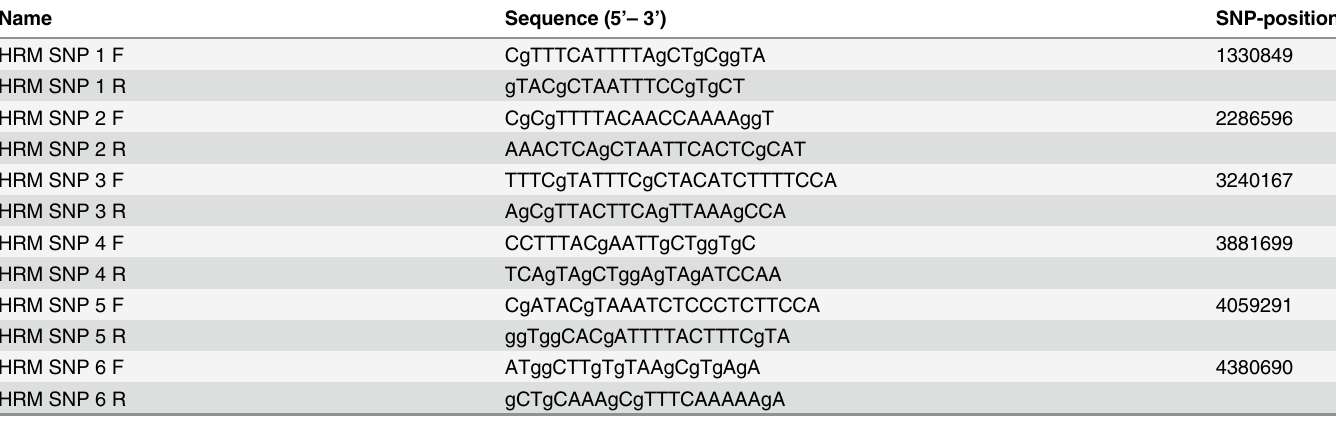
Table 3. Oligonucleotides used for high resolution melting analysis of